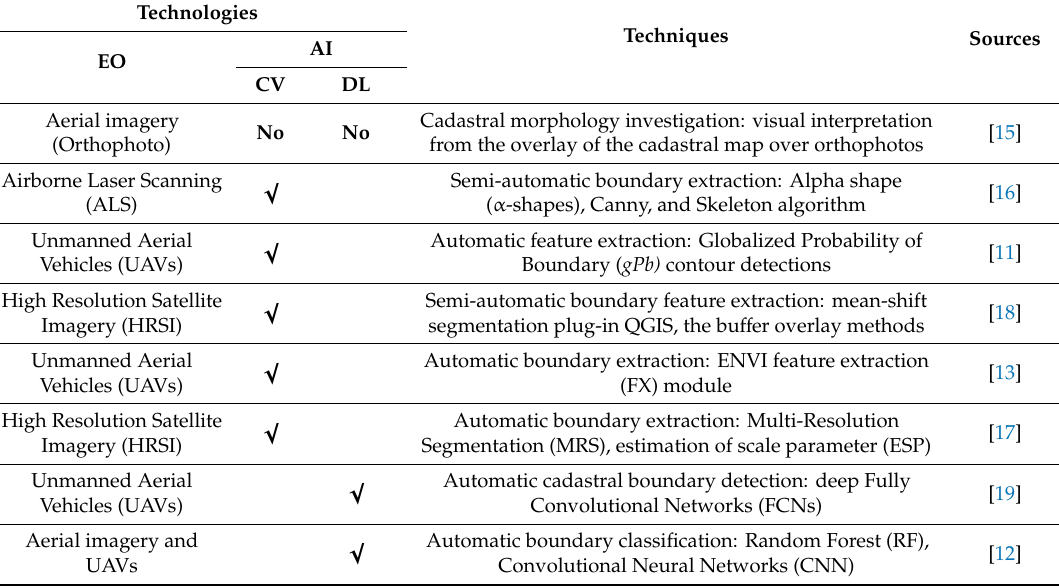
Table 2. Earth Observation (EO) data and Artificial Intelligence (AI) delves deeper into the future of land administration and the advanced techniques substitute to a certain extent the feature and boundary extraction for cadastral mapping. However, a number of critical questions remain about the interpretation of semantic land tenure relations using both EO and